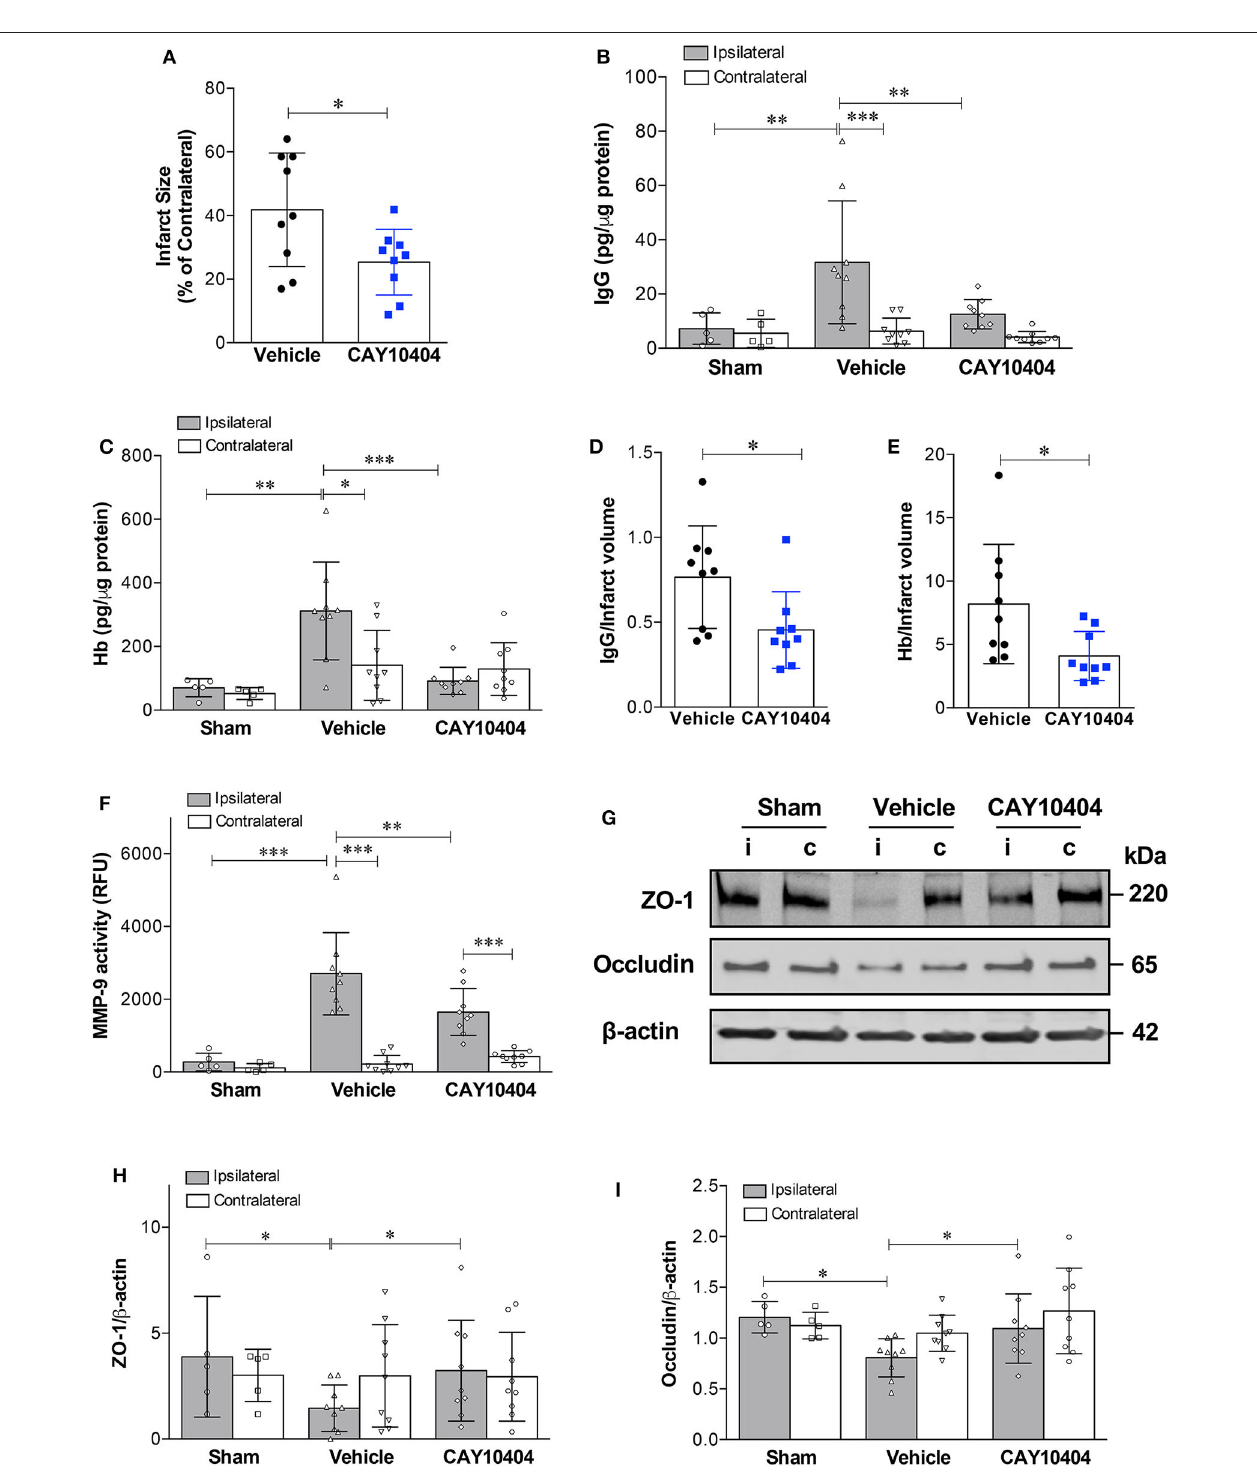
FIGURE 5 | Pharmacological inhibition of COX-2 protects against stroke-induced BBB damage, hemorrhagic transformation, increased MMP-9 activity, and loss of tight junction proteins. CAY10404, a highly selective COX-2 inhibitor, was administered intraperitoneally at the start of reperfusion to wild-type mice subjected to MCAO. Ischemic controls received the vehicle. (A) Treatment with CAY10404 significantly reduced infarct size at 24h after stroke. Unpaired t -test, * P < 0.05. (B) Extravasation of IgG into the ischemic cerebral cortex was significantly reduced by post-ischemic CAY10404 administration. Two-way ANOVA with Bonferroni post-hoc test. ** P < 0.01 and *** P < 0.001. (C) Reduced hemorrhagic transformation in CAY10404-treated mice at 24h after stroke, as quantified by brain